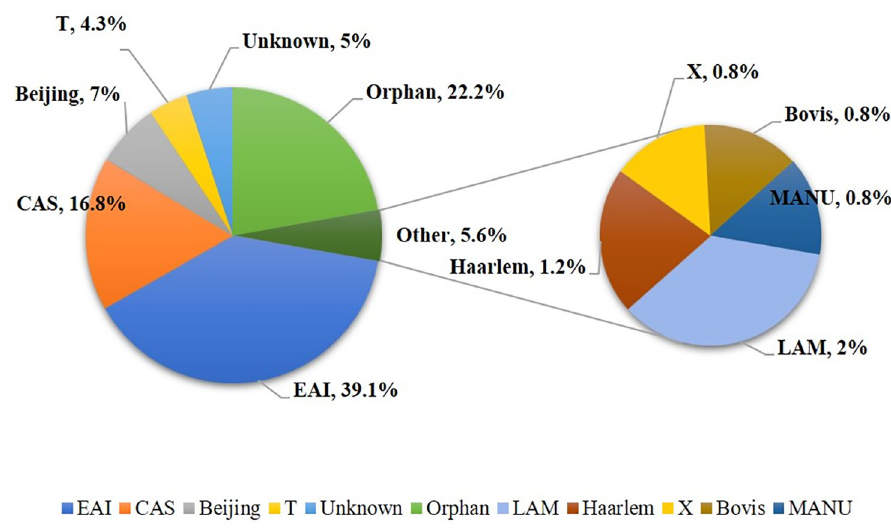
Fig 1. Pie chart showing the distribution of M . tuberculosis lineages (in percentages) prevalent in Kuwait on the basis of SITVIT2 WEB analysis. EAI, CAS and Beijing lineages were dominant.